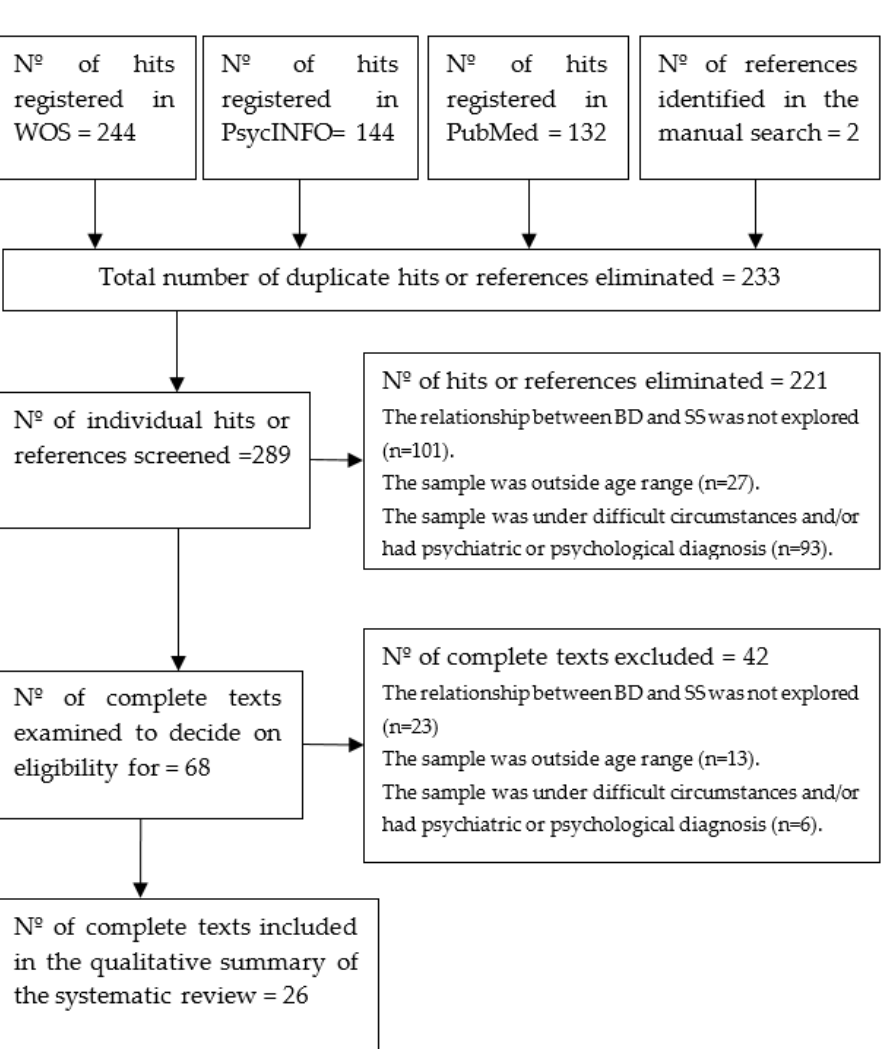
Figure 2. Flow Diagram of the Preselection and Selection Phases.